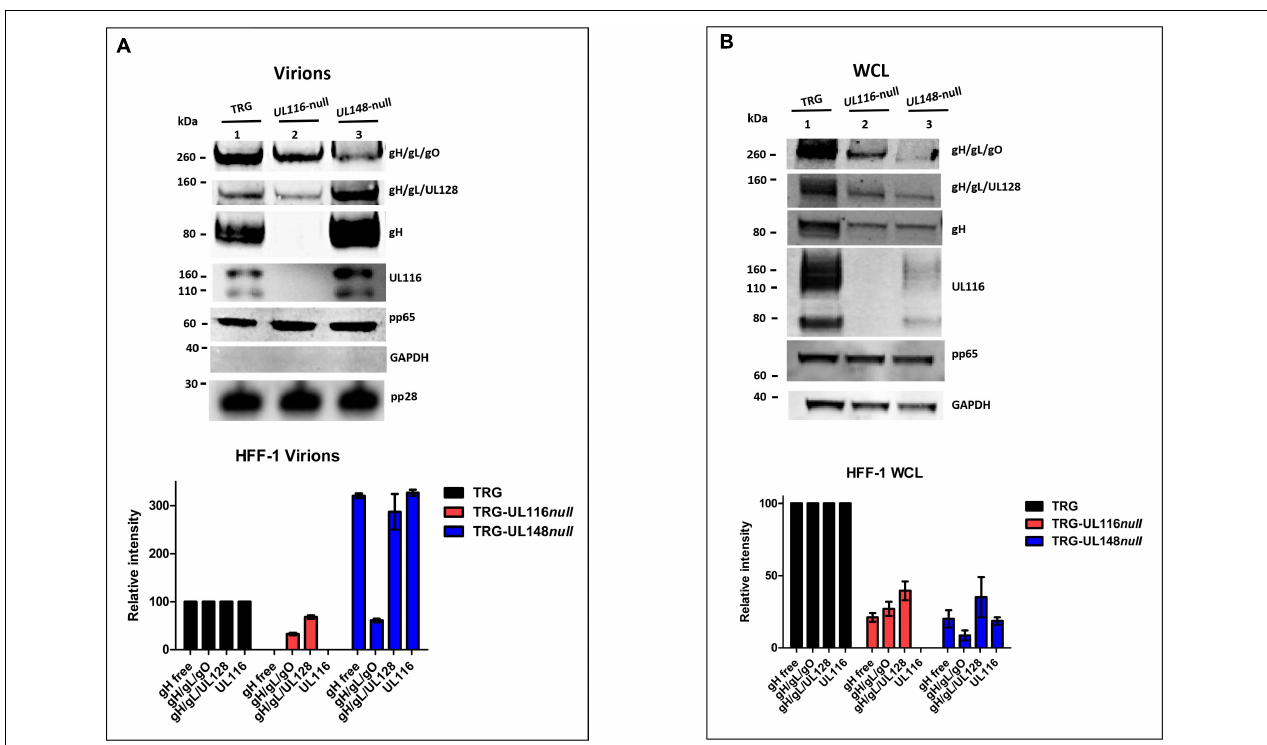
FIGURE 3 | Loss of UL116 or UL148 gene products alters the ratio of gH/gL complexes in HFF-1 cellular extracts and virions. UL116, pp65, pp28, and GAPDH were revealed under reducing conditions. gH, gH/gL/gO, and gH/gL/UL128 were probed with anti-Pentamer polyclonal antibodies under non-reducing conditions. Western blots are representative of at least three independent experiments. At the bottom, densitometric analysis of the corresponding immunoblot are shown. Densitometric values of complexes present in the wt virus are considered 100%. The standard deviation indicated in graphs were obtained by the densitometric values from three independent experiments and normalized on the intensity of the pp65 viral marker. Viruses used for infection are indicated on the top of each lane. (A) Viral pellets from a T75 flasks were lysed in 50 µ l of TX-100 lytic buffer. 5 µ l aliquots were run SDS-PAGE under reducing conditions, transfered to a nitrocellulose membrane and probed with anti-pp65. Intensity whose levels of the pp65 bands were used to normalized the consecutive loads. Two aliquots of each sample were then loaded on 4–12% PAGE-SDS under reducing and non-reducing conditions, respectively, and treated for immunoblotting. Virus lysates are indicated on the top of each lane (B) Equal amount of total proteins (BCA) from 7 DPI whole cell lysates (WCL) of HFF-1 were separated (NuPage, Invitrogen) and treated for western blot